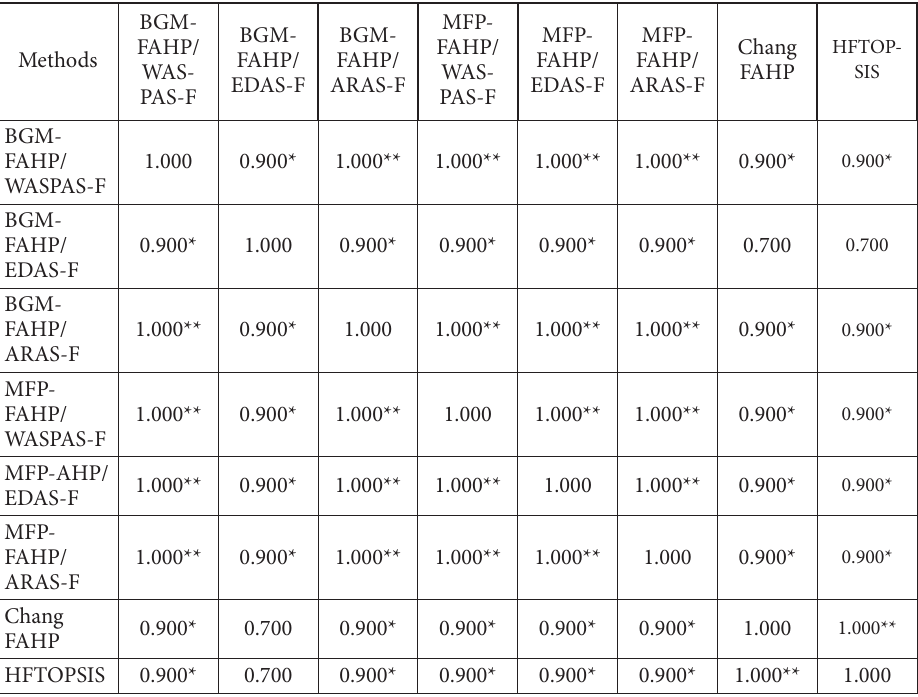
Table 13. Correlations between ranking results of proposed integrated FMCDM methods, FAHP and HFTOPSIS